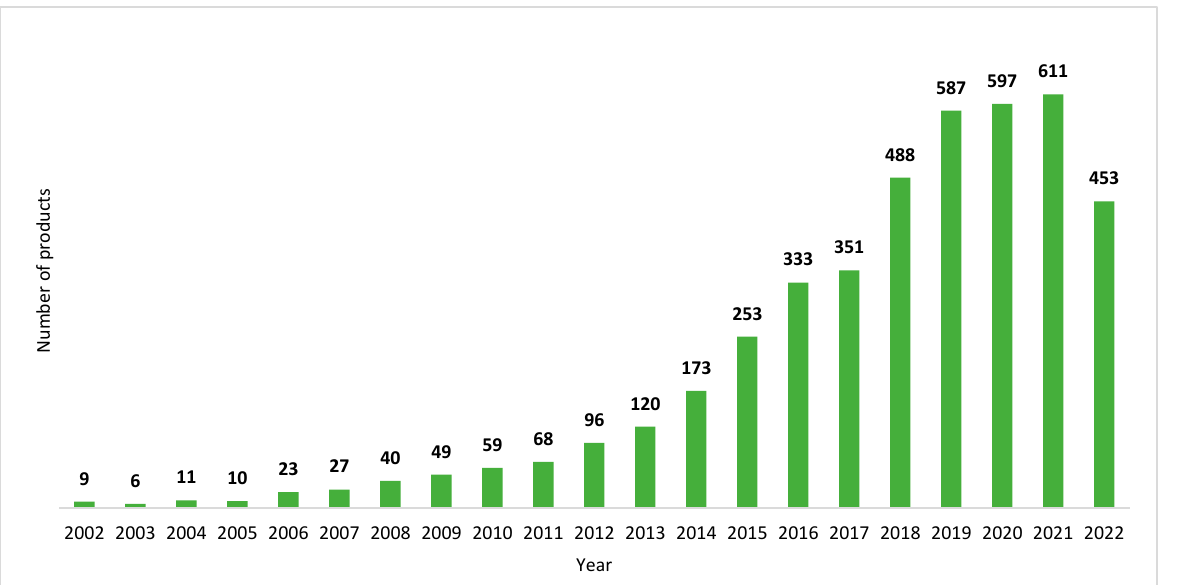
Figure 2. Evolution of launches of fermented plant-based foods in the global market. A search was conducted on Mintel GNPD (Global New Products Database) on 15 September 2022. Date: from 1 January 2002, to 15 September 2022. The inclusion criteria of the search were as follows: the Super-Category matches Food and Drink, the Claims match one or more of [Vegan/No Animal Ingredients; Plant Based], and Ingredient Search matches Fermented as one of the Ingredients. A total of 4379 products were retrieved. Table 1. Fermented plant-based foods sold in the global